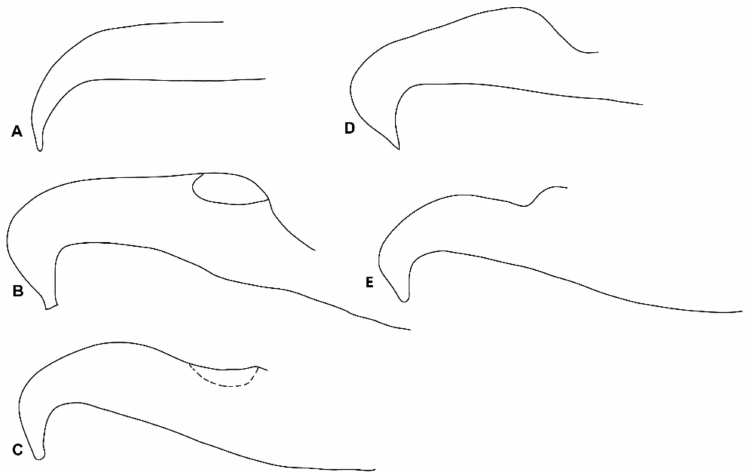
Figure 10. Different aedeagus shapes of Oligonychus vitis; ( A ) redrawn from original description [19], and redrawn from various redescriptions; ( B ) [7], ( C ) [3], ( D ) [13] and ( E ) [17]. The molecular data obtained from the ITS2 and COI sequences support the syn- onymy of O. mangiferus with O. punicae . The obtained intraspecific range (0% to 2.1%;) of the nucleotide diversity using the ITS2 sequences of the punicae complex from Egypt, Israel, India, Pakistan, and SA, aligns well with previous findings on different tetranychid species [29,31,34,35,54]. Previously, the ITS2-intraspecific sequence divergence ranged between 0% and 2% ( ≤ 2%) in various tetranychid species, including the three Oligonychus species of O. afrasiaticus (McGregor) , O. mangiferus , and O. perseae (Tuttle, Baker and